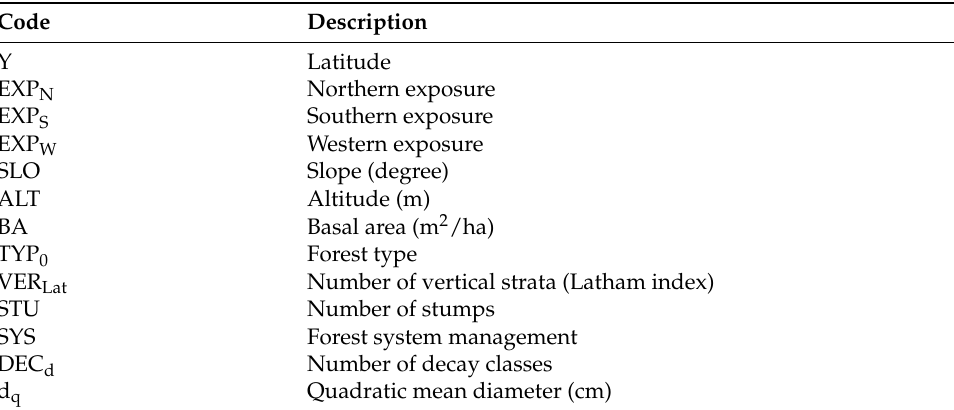
Table 4. List of independent variables resulting from the best-performing model (DIC = 1871.154) to study forest and topographic effect on proxies of Apennine brown bear food: code and description. Reference class: beech forest type (TYP = 1), high forests (SYS = 0).